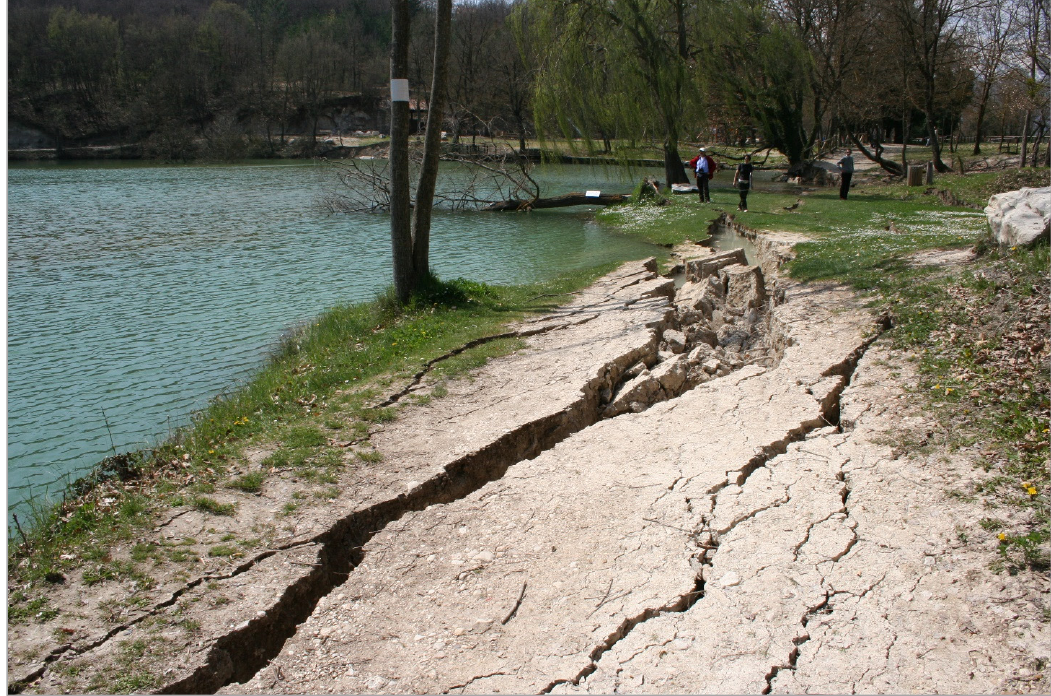
Figure 10. Open cracks and shore disruption at Sinizzo Lake (Abruzzo, Italy) after the L’Aquila earthquake on 6 April 2009 (Mw 6.3).